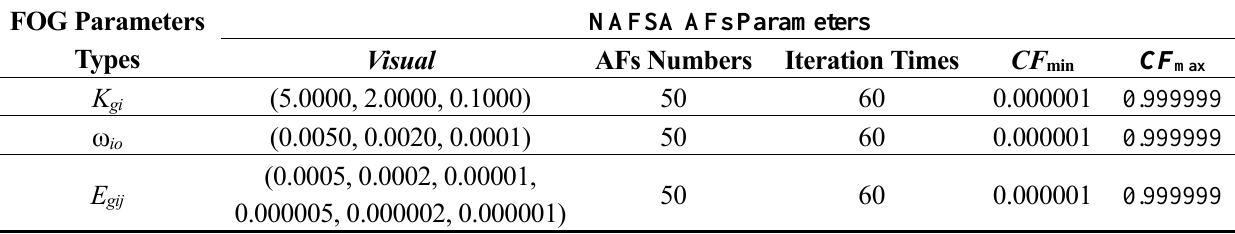
Table 1. Novel artificial fish swarm algorithm (NAFSA) tri-axial fiber optic gyroscope (FOG) preset artificial fishes (AFs) parameters.